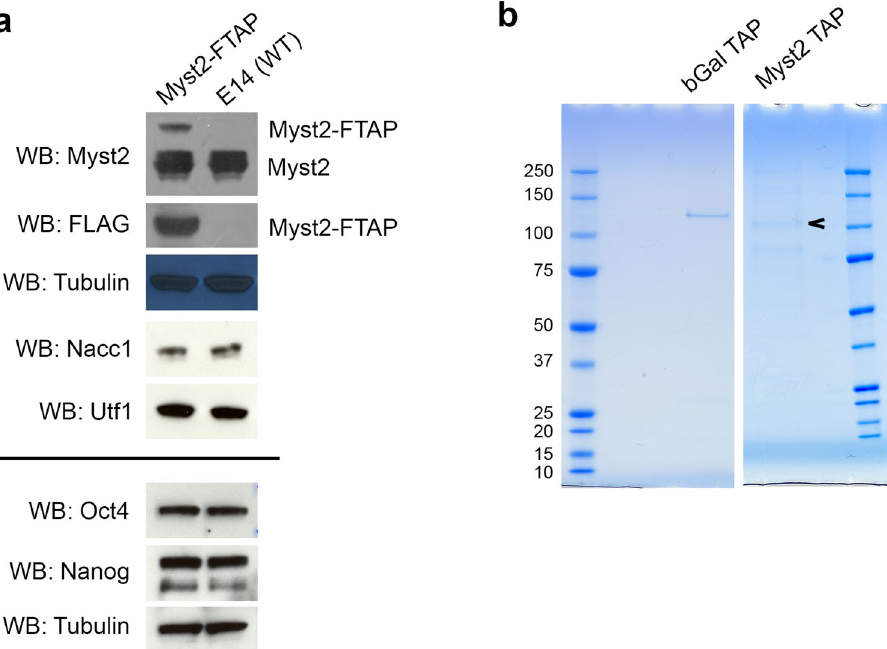
Figure 2. Affinity purification of Myst2 protein complexes from mouse ES cells. ( a ) Whole cell lysates of Myst2-FTAP and wild type E14 cells were probed by Western blotting (WB) with antibodies against Myst2, FLAG, beta-tubulin, Nacc1, Utf1, Oct4 and Nanog. Full-length blots are presented in Supplementary Fig. S3. ( b ) Coomassie-stained gels of proteins co-purifying with Myst2 or control beta-gal in ES cells in tandem affinity purification (TAP). The band corresponding to tagged Myst2 is marked with an arrow. Molecular weight markers are shown (in